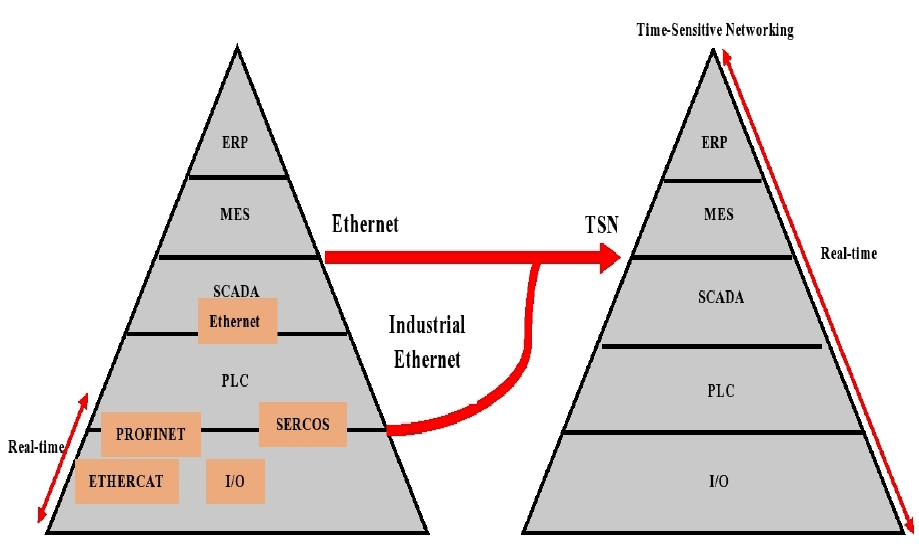
Figure 6. TSN implementation on the automation pyramid